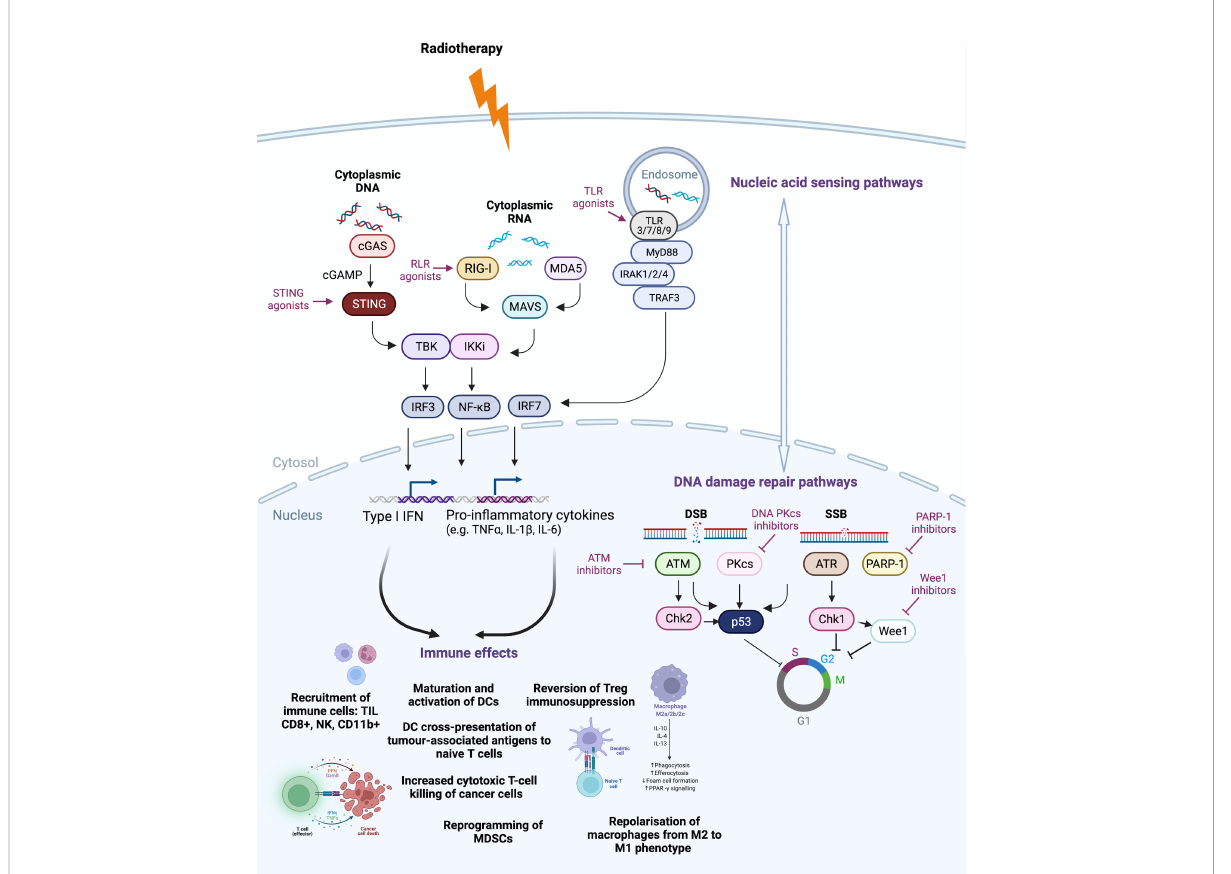
FIGURE 1 Druggable targets of the DNA damage response (DDR) pathway currently tested in clinical trials. Radiotherapy induces DNA damage and cell death. Nucleic acid sensing pathways detect cytoplasmic DNA and RNA to stimulate downstream pathways. Cytoplasmic DNA activates the Cyclic GMP – AMP synthase (cGAS) to produce cyclic GMP – AMP (cGAMP) that activates the stimulator of interferon genes (STING) pathway, leading to type I interferon (IFN) production. Radiotherapy-induced type I interferon (IFN) can induce RNA sensor activation through RNA polymerase III conversion of DNA to double-stranded RNA (dsRNA), radiotherapy-induced small non-coding RNA (sncRNA) or STAT1-induced dsRNA synthesis from endogenous retroviral elements (ERVs). These activate (RIG-I)-like receptors (RLRs), melanoma differentiation-associated protein 5 (MDA5) and retinoic acid-inducible gene-I (RIG-I), which also drives pro-in fl ammatory signalling through type I IFN and pro- in fl ammatory cytokine production. Toll-like receptors (TLRs) can recognise damage-associated molecular patterns (DAMPs) of single-stranded RNA (ssRNA), dsRNA or unmethylated CpG DNA in intracellular compartments such as endosomes, to lead to activation of nuclear factor- k B (NF- k B), mitogen-activated protein kinase (MAPKs) and interferon regulatory factors (IRFs). DNA damage repair mechanisms of single- (SSB) and double-strand breaks (DSB) are often upregulated by cancer cells to avoid cell cycle arrest or death. Inhibitors of DNA damage repair components, such as ataxia telangiectasia- mutated (ATM), ataxia telangiectasia and Rad3-related protein (ATR), DNA-dependent protein kinase, catalytic subunit (DNA-PKcs), poly(ADP- ribose) polymerase 1 (PARP-1) and Wee1 (Wee1-like protein kinase) function to propel the cell through the cell cycle, despite the presence of unrepaired damage, leading to accumulation of cytosolic DNA. This leads to cross-talk with the nucleic acid sensing pathway via activation of the cGAS-STING pathway and dsRNA stress pathway via promotion of ERV expression. These two pathways, through positive and negative cross-talk, shape the radiotherapy-induced DDR response that feeds into anti-tumour immune effects, including recruitment of tumour-in fi ltrating CD8+ T-cells, natural killer (NK) cells and CD11b+ innate immune cells, such as macrophages and neutrophils. Maturation and activation of dendritic cells (DCs) is increased, including DC cross-presentation of tumour-associated antigens to naive T-cells, which can become activated leading to T-cell-mediated cytotoxic-killing of cancer cells. Furthermore, the immunosuppressive effects of myeloid-derived suppressor cells (MDSCs) and regulatory T-cells (Tregs) can be reversed and macrophages can be repolarised from M2 to an M1 pro-in fl ammatory phenotype. Chk, checkpoint kinase; IKKi, inducible I k B kinase; IL, interleukin; IRAK, Interleukin 1 Receptor- Associated Kinase; MAVS, mitochondrial anti-viral-signalling protein; MyD88, Myeloid differentiation primary response 88; TBK, TANK-binding kinase 1; TNF a , tumour necrosis factor alpha; TRAF3, TNF Receptor-Associated Factor 3. Created with